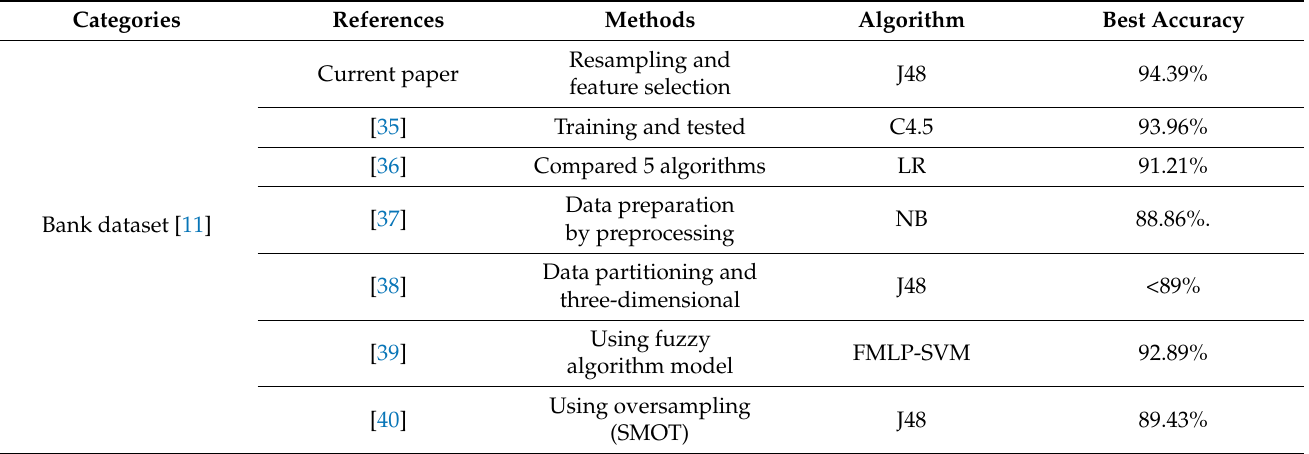
Table 4. Metrics comparison with previous